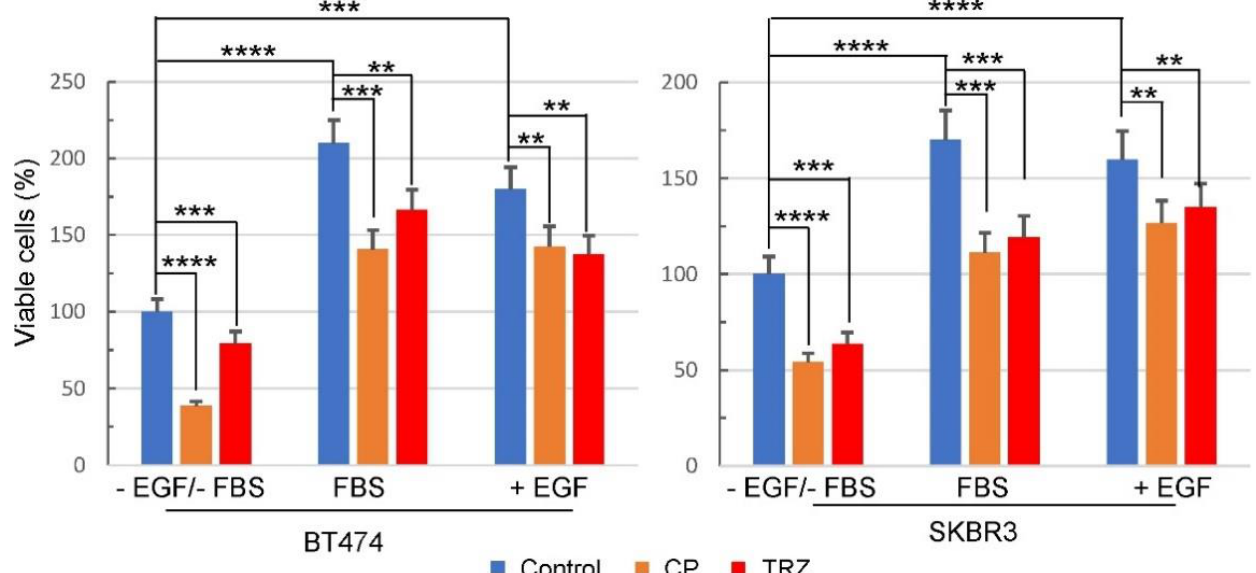
Figure 1. The effects of trastuzumab (TRZ) on the viability of BT474 and SKBR3 breast cancer cells in absence and presence of 10% FBS, and EGF. Cells were treated with 10 µg/mL concentration of trastuzumab for 72 h. Cells treated with normal human IgG were used as negative control and cells treated with CP–714724 (CP) at 1 µM concentration were used as positive control. Each value is the average of at least three experiments and the error bar is standard error. **: p < 0.01, ***: p < 0.001, ****: p < 0.0001.